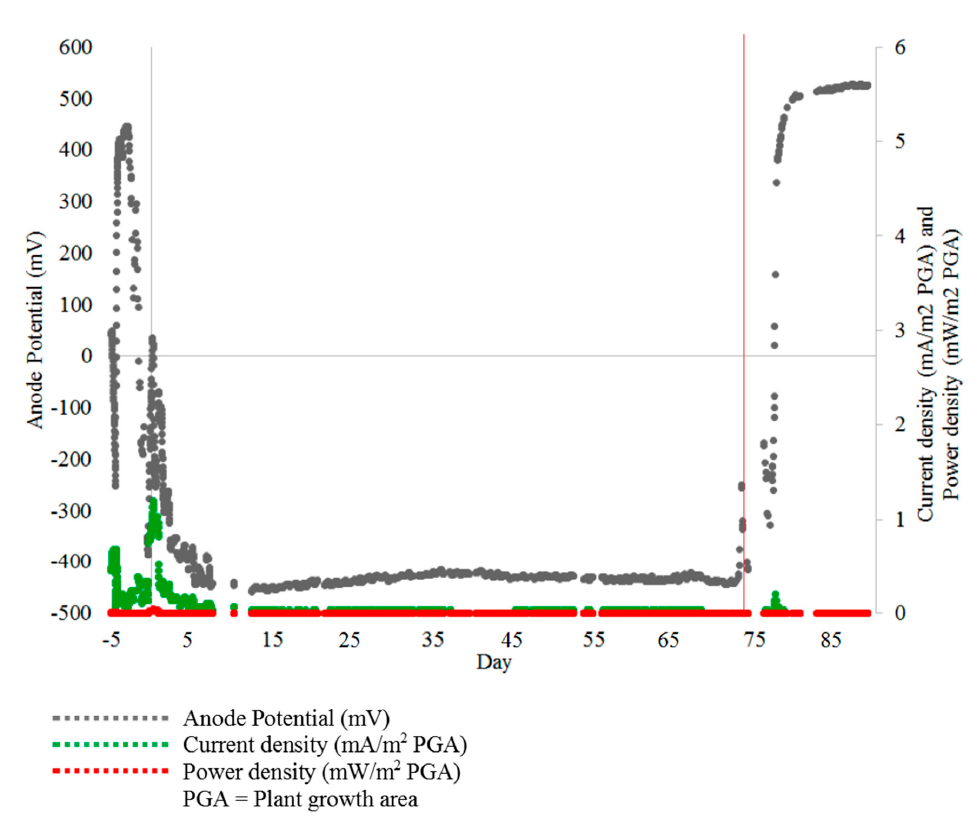
Figure 11. Anode potential, Current density and Power density of Plant-MFCs with ( a ) PU / AC